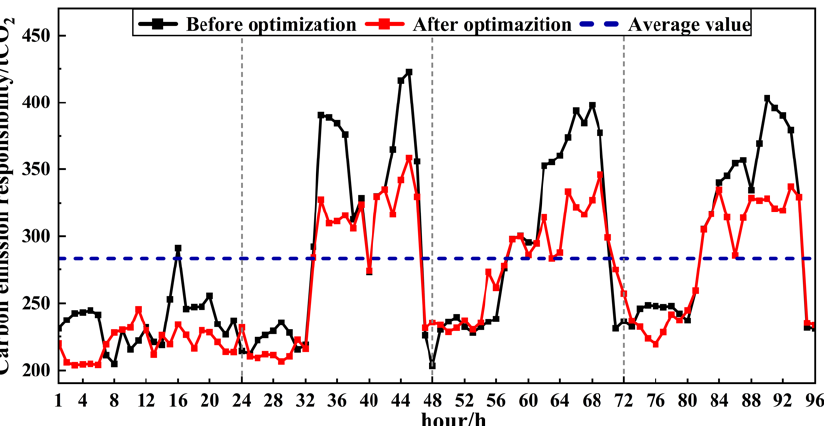
Figure 12. Carbon emission responsibility of the load at bus 3 before and after the EES configuration.